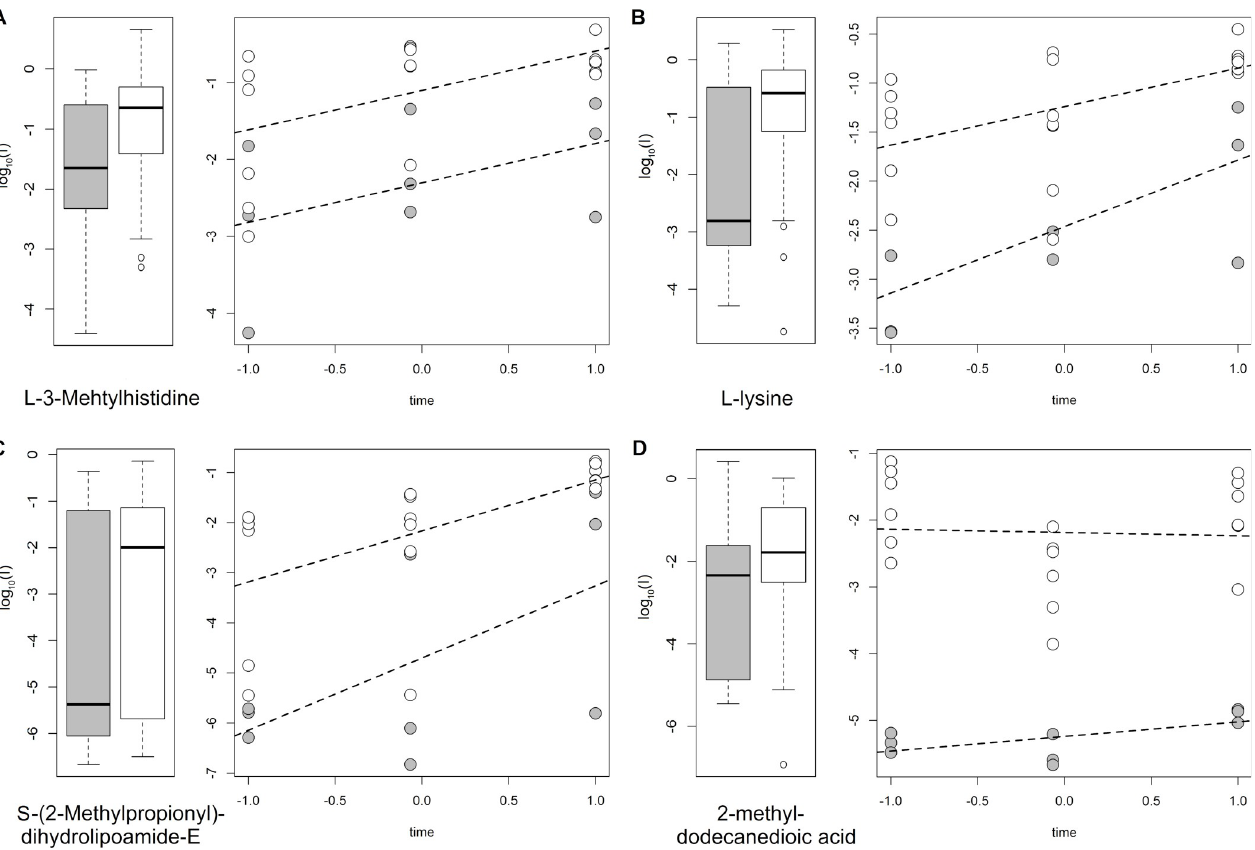
Fig 3. Boxplots showing the distribution of the relevant metabolites considering the first collected urine samples and the trends of the same features during TH, as obtained from the fixed effects of the LME models; grey is used for “HIE” patients, and white for “no HIE” patients.